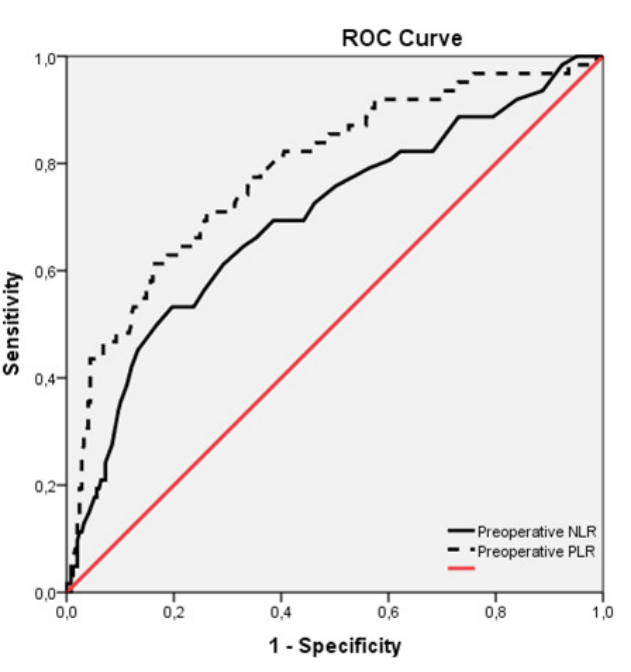
Fig. 1 - ROC curve analysis or preoperative PLR and NLR regarding occurrence of postoperative